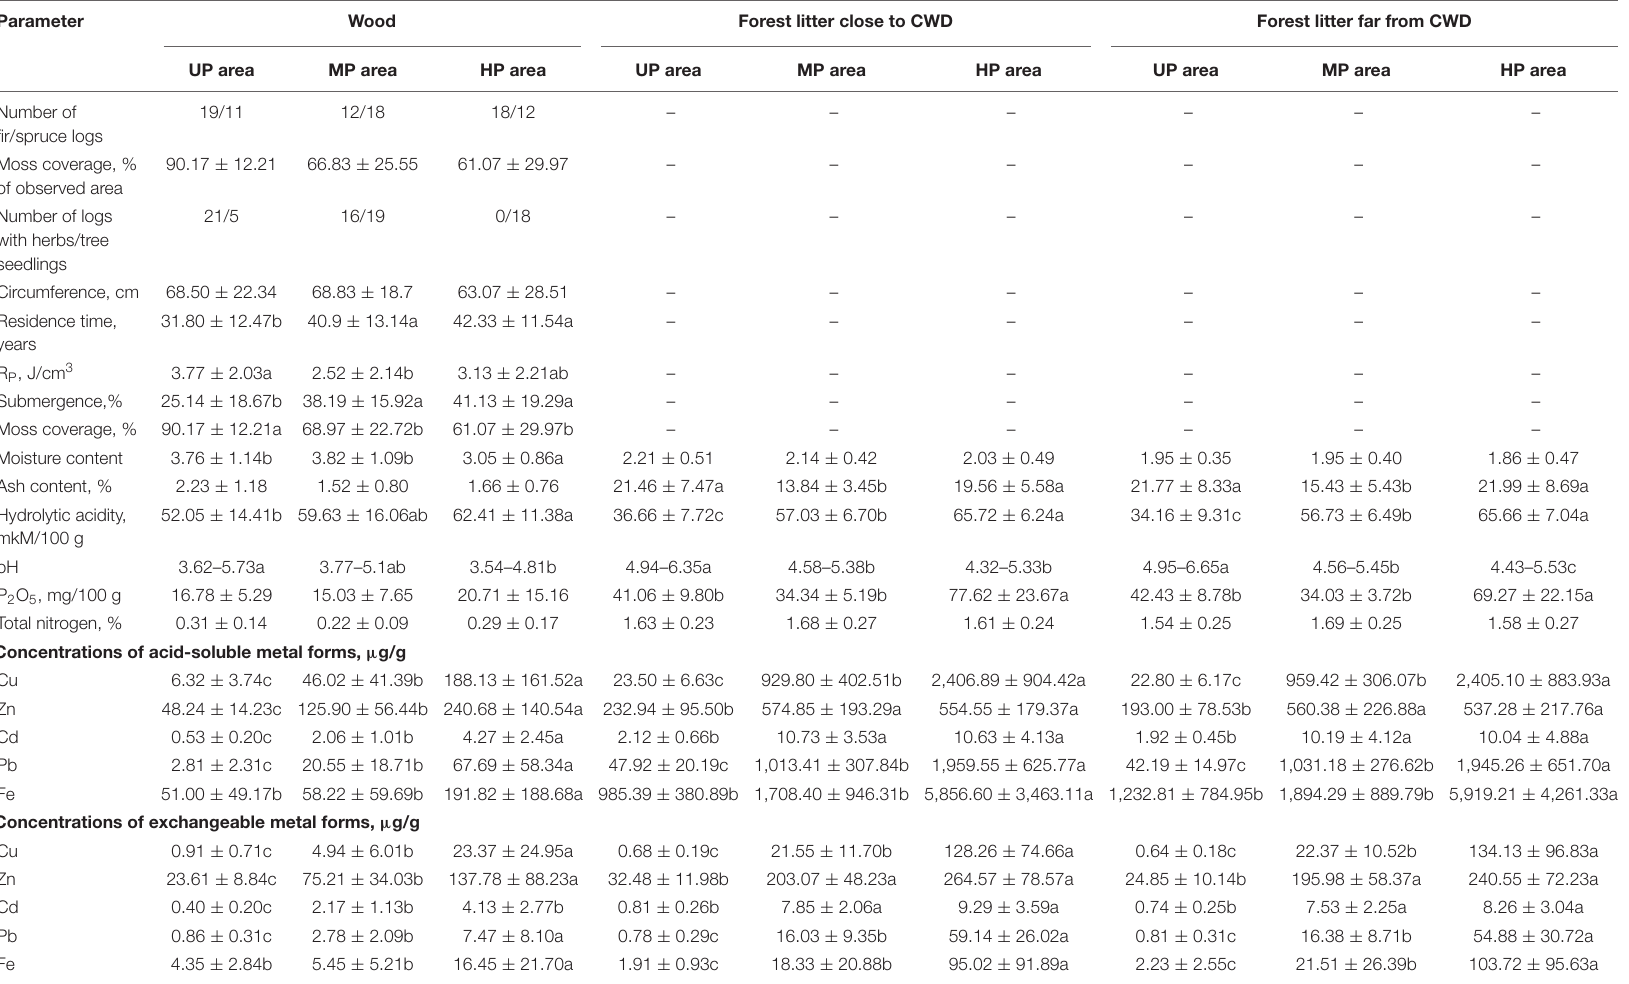
Mean values and standard deviations are shown; minimal and maximal values are provided for pH; n = 30 samples. Different letters depict statistically significantly different mean values between areas for a particular substrate (Tukey’s test, α = 0.05). CWD, coarse woody